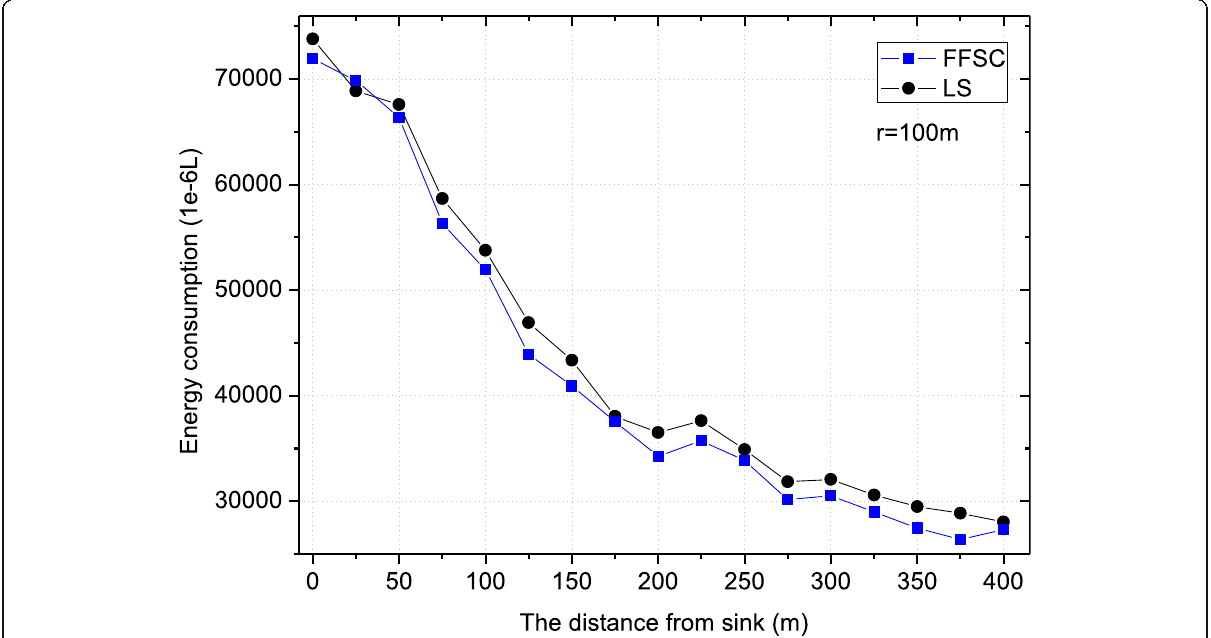
Fig. 15 The energy consumption under different distance from